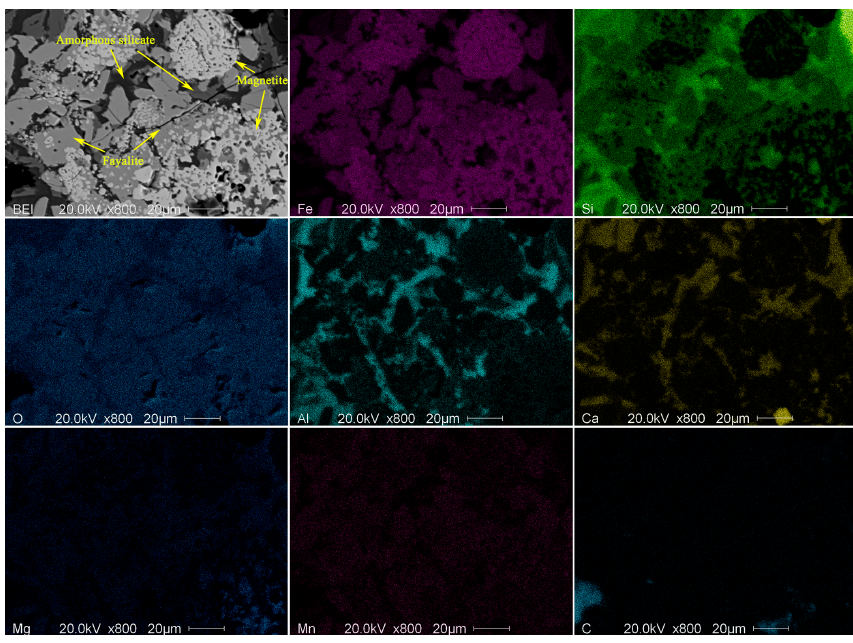
Figure 8. EDS elemental mapping of deposit sample.